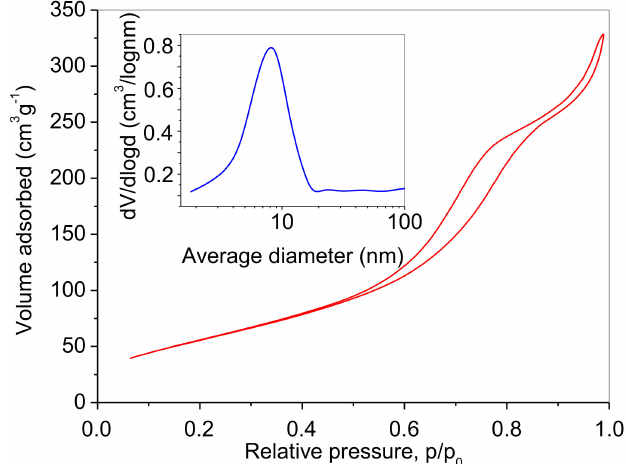
Figure 8. N 2 adsorption–desorption isotherm of the prepared photocatalyst. Inset: Pore size distribu- tion obtained from the desorption